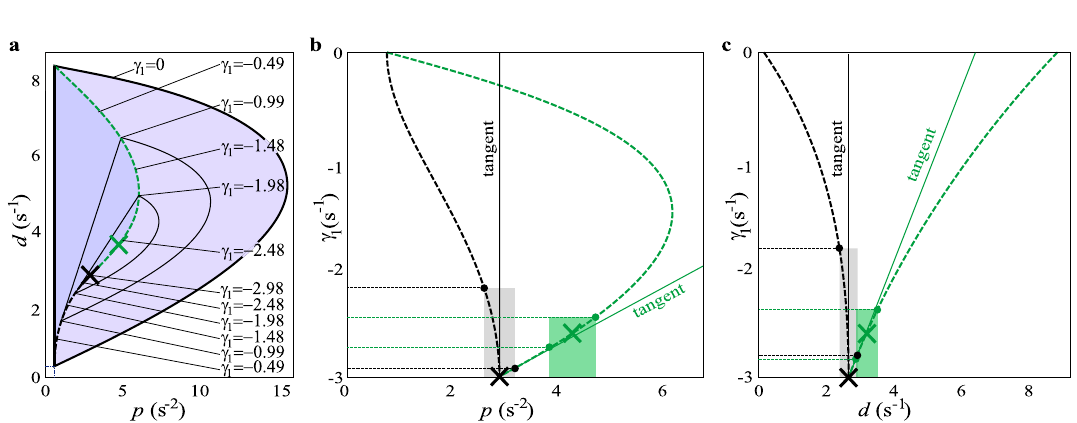
Figure 4. ( a ) Change of the exponential decay rate γ 1 along the node-spiral separation line. Parameters corresponds to Subject 9. ( b,c ) Dependence of γ 1 as function of p and d along the node-spiral separation line. ± 10 % perturbation of the gains ( p ∗ , d ∗ ) and ( ˆ p , ˆ d ) and the resulted change in γ 1 is shown by grey and green shading,